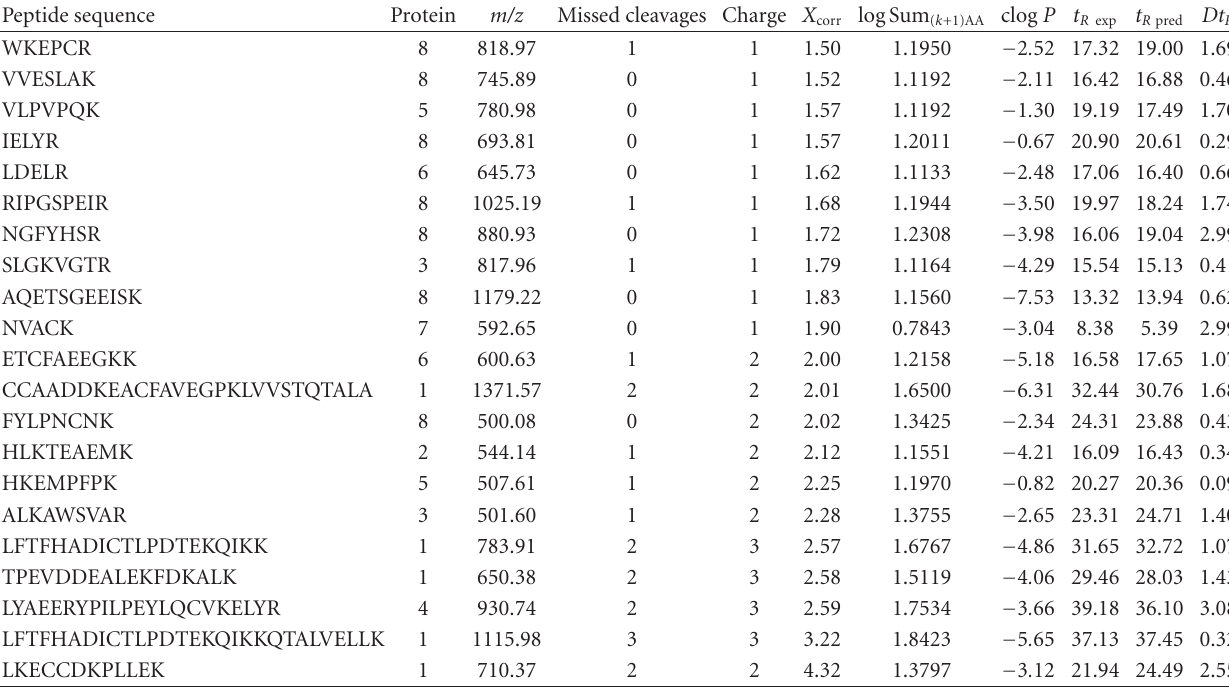
Table 2: Test peptides obtained from a set of model proteins and used to check the validity of the proposed QSRR model. Peptide sequence